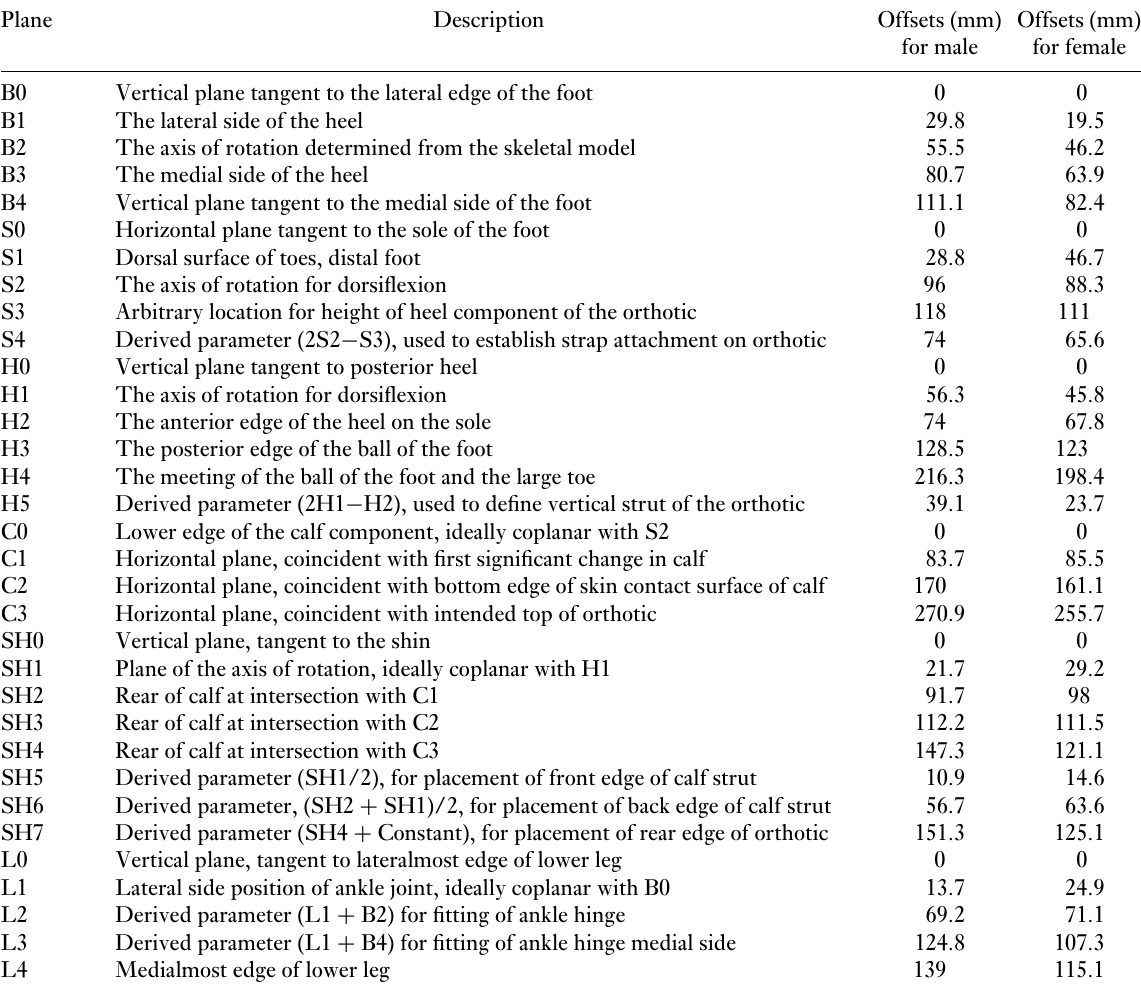
Table 1 Landmark parameterisation of the foot and lower leg